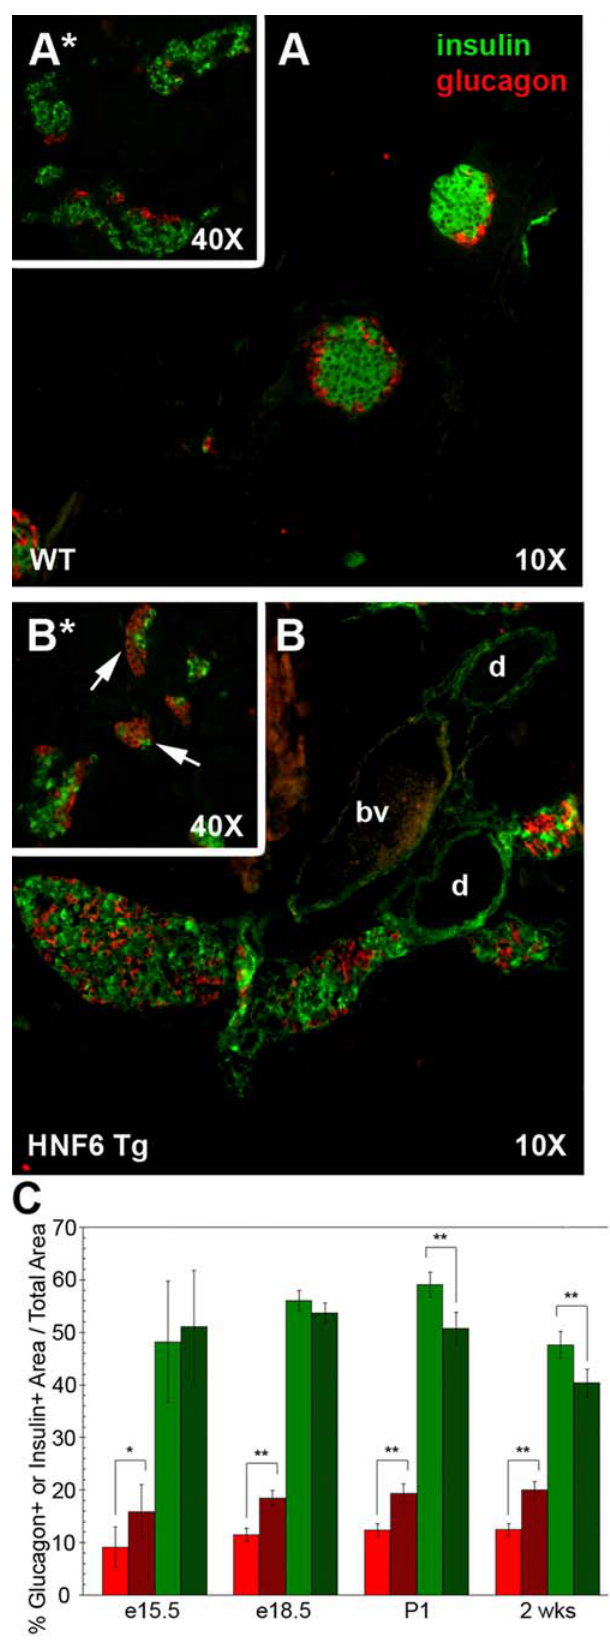
r Figure 1. Hnf6 Tg animals exhibit abnormal islet morphogen- esis. (A) Islet from a four week old WT animal showing insulin- producing b cells at the islet core (green) and glucagon-producing a cells at the periphery (red). (B) At the same age, individual Hnf6 Tg islets are larger, have a mixed islet phenotype, and are closely apposed to the ductal epithelium. (A*, B*) At e18.5, WT endocrine cells have begun to adopt the stereotypic architecture; however, Hnf6 Tg a cells are often clustered together in islet-like structures that have few, if any, b cells (arrows in B* ). (C) Morphometric analysis demonstrates increased glucagon + cell area (red) as early as e15.5 in Hnf6 Tg islets (dark red). This relative increase over WT islets (solid bars) persists into postnatal stages. Total insulin + area decreases in transgenic animals (dark green) at postnatal stages, but does not appear to be altered during embryogenesis. e15.5, n=4; e18.5, n=4; P1, n=2; 2 weeks, n=3. Error bars were determined by 95% confidence interval. * p , 0.05, ** p , 0.005, as determined by Student’s t-test. d , duct; bv , blood